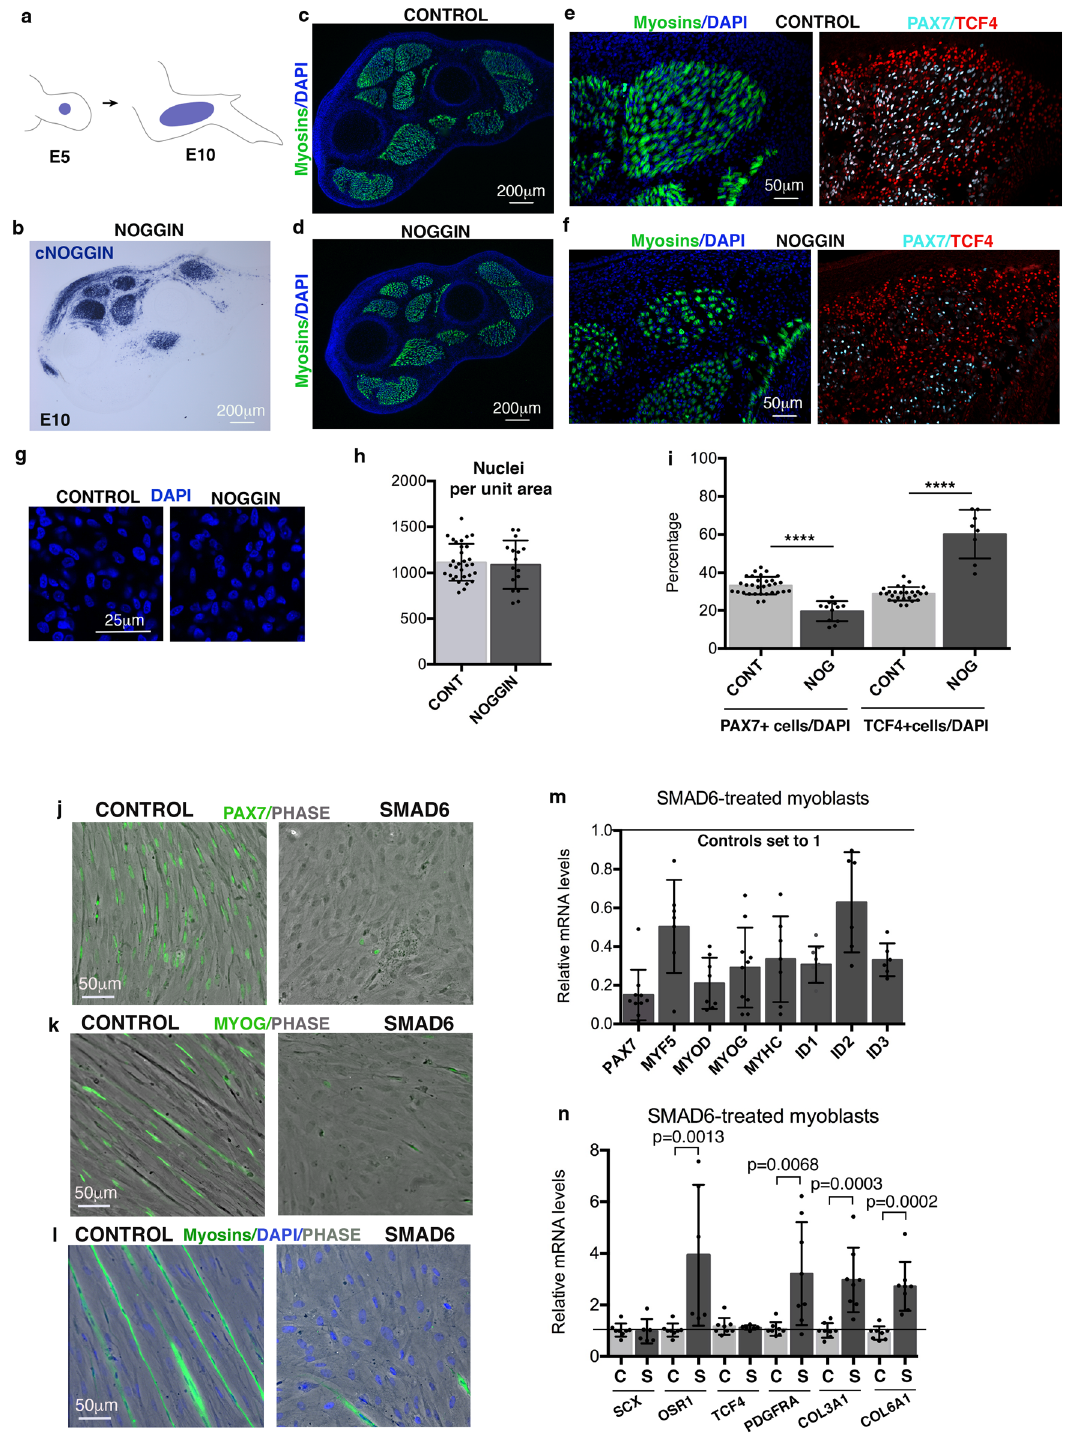
Surgical grafting experiments in avian embryos Isotopic/Isochronic quail- or GFP + chicken-into-chicken grafts of presomitic meso- derm . Quail, GFP + chicken and chicken embryos were incubated until they reached 15-somite stage. Of note, limb buds are not formed at this stage and brachial somitic cells have not yet migrated into the forelimb presumptive regions. An arti fi cial dark fi eld was obtained by injecting Indian ink, diluted 1:1 in PBS, beneath the chicken host embryos. Microsurgery was performed on the right side of the host embryos. The 15th somite and the non-segmented presomitic meso- derm was removed over a length corresponding to 5 – 8 somites. Presomitic mesoderms from either quail ( N = 6) or GFP + chicken ( N = 4) donor embryos were rinsed in DMEM (PAA Laboratories)/10% foetal calf serum (FCS, Eurobio) and transplanted into chicken hosts submitted to the same ablation. Grafts